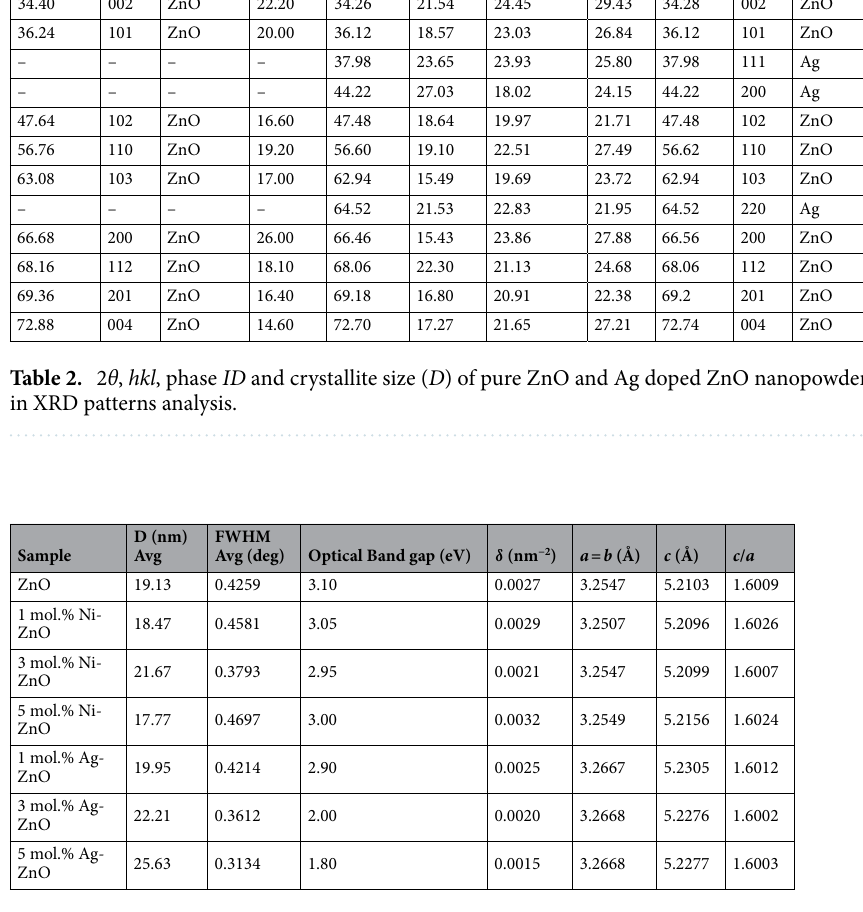
Table 3. The average crystalline size, lattice parameters, average FWHW and dislocation density of pure ZnO, Ni doped ZnO and Ag doped ZnO nanopowders.